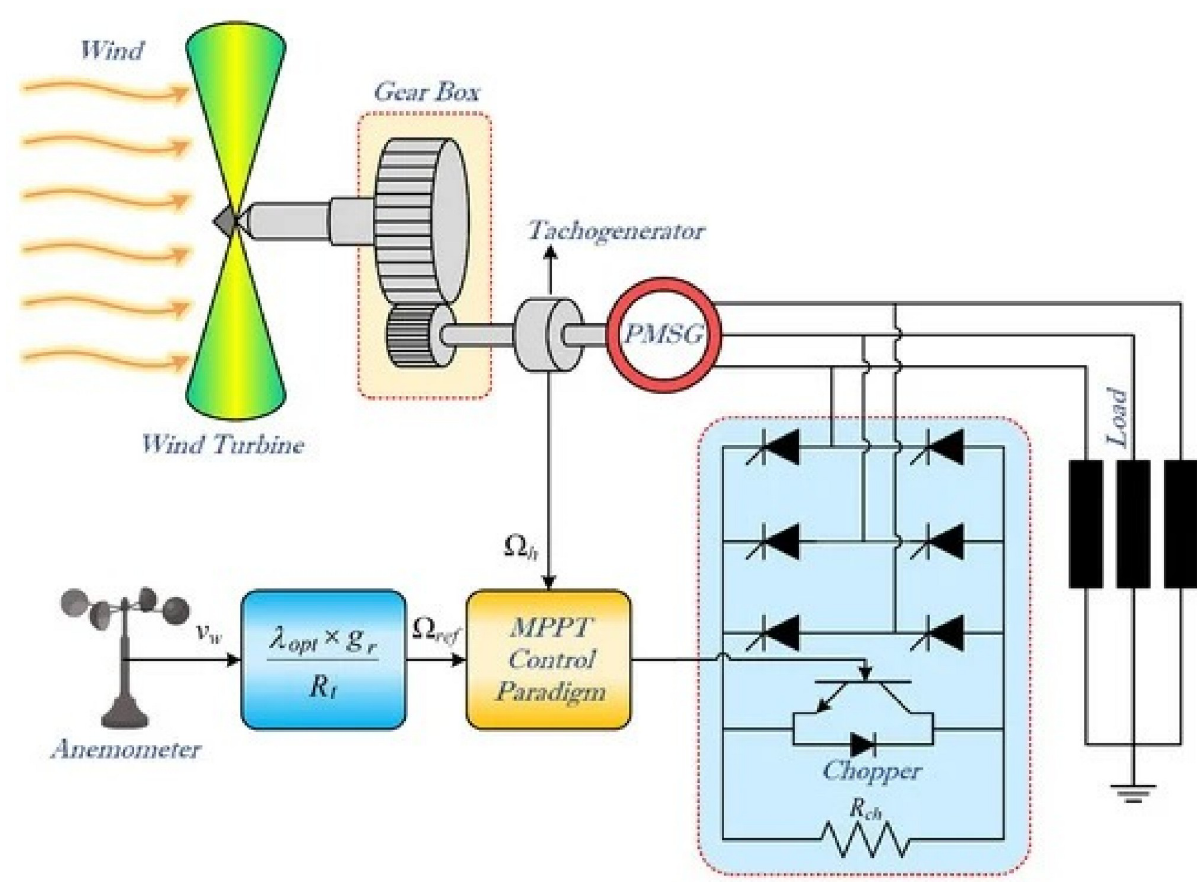
Fig 2. Schematic of the overall system, i.e., PMSG-based WECS.